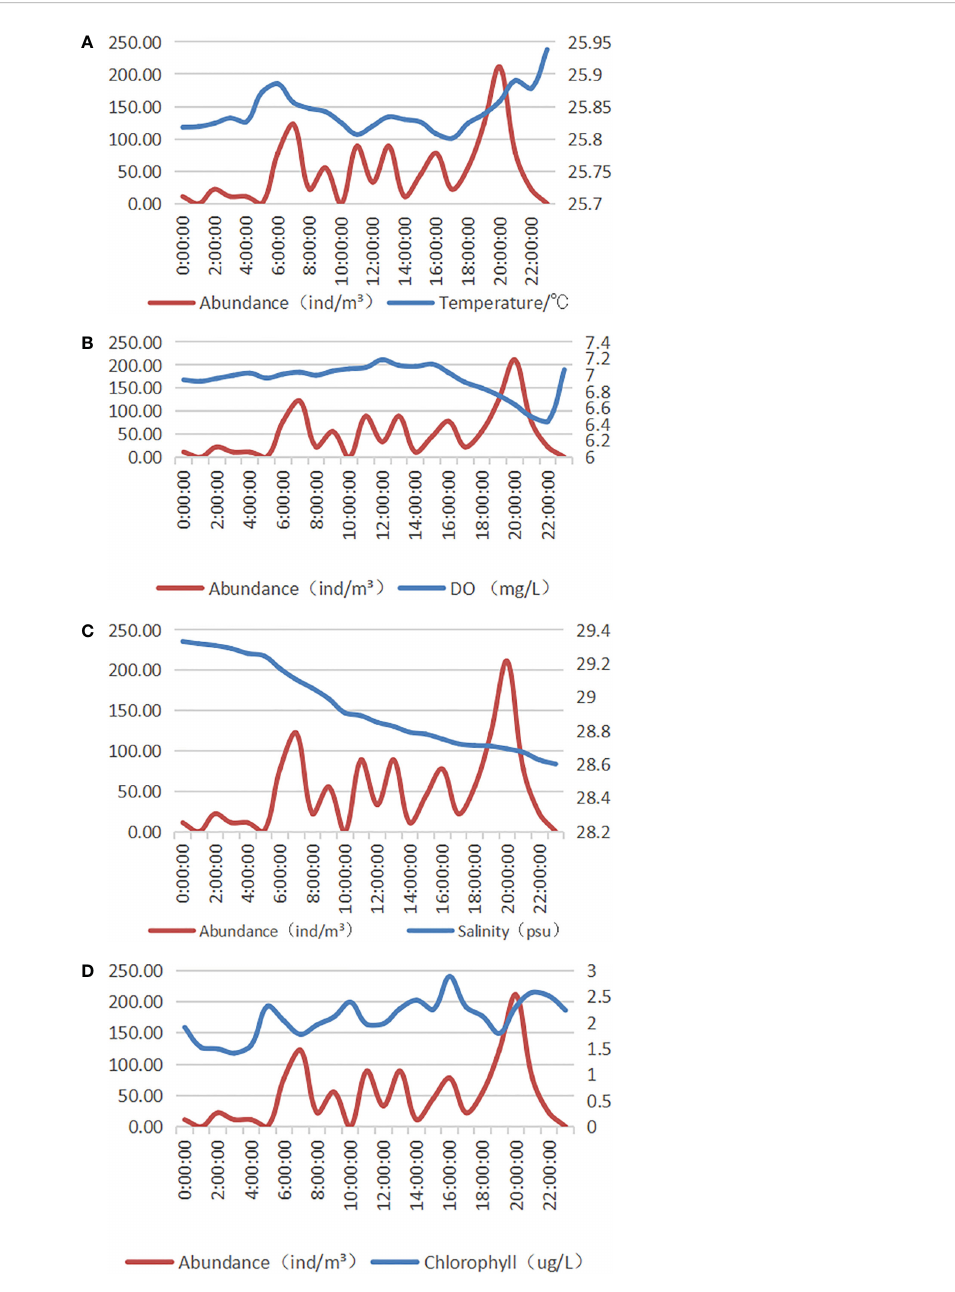
FIGURE 3 Input and output correlation analysis. (A) Correlation analysis between the abundance and temperature of tip pen cap snails. (B) Correlation analysis between the abundance of tip cap snails and dissolved oxygen. (C) Correlation analysis of spikelet abundance and salinity. (D) Correlation analysis between the abundance of pointy pen cap snails and chlorophyll.